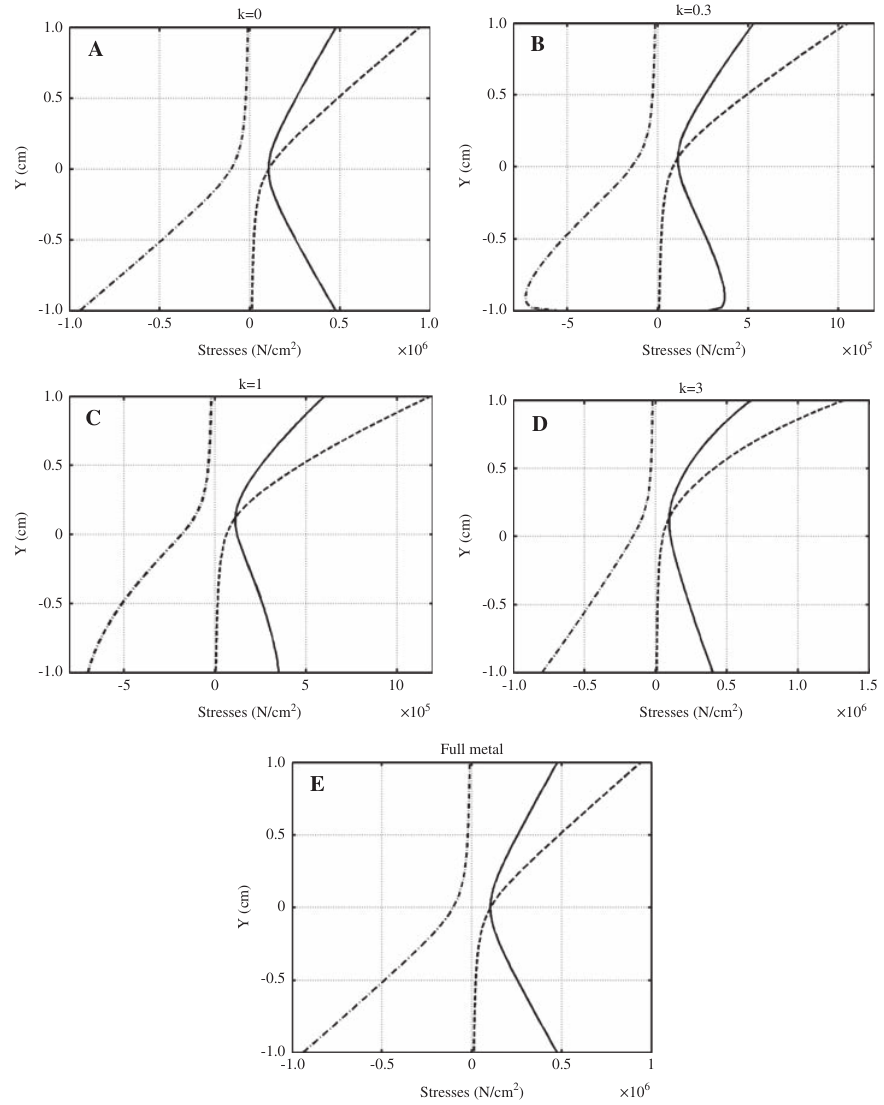
Figure 14 The principal stresses 0 σ q = 500 N/cm 2 in the geometrically linear case, 0 σ